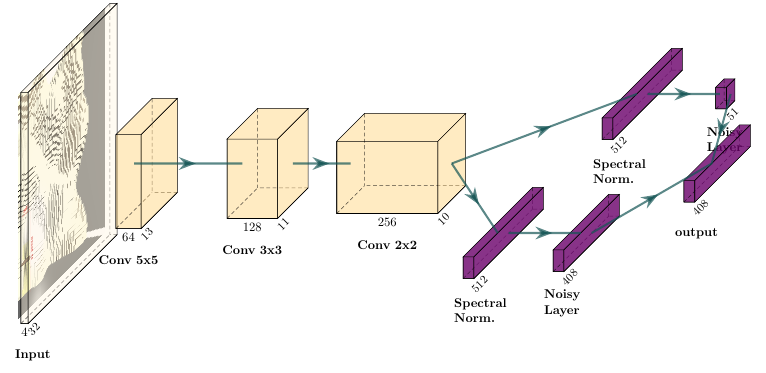
Figure 17. Shallow network structure with an input of size 4 × 32 × 32.